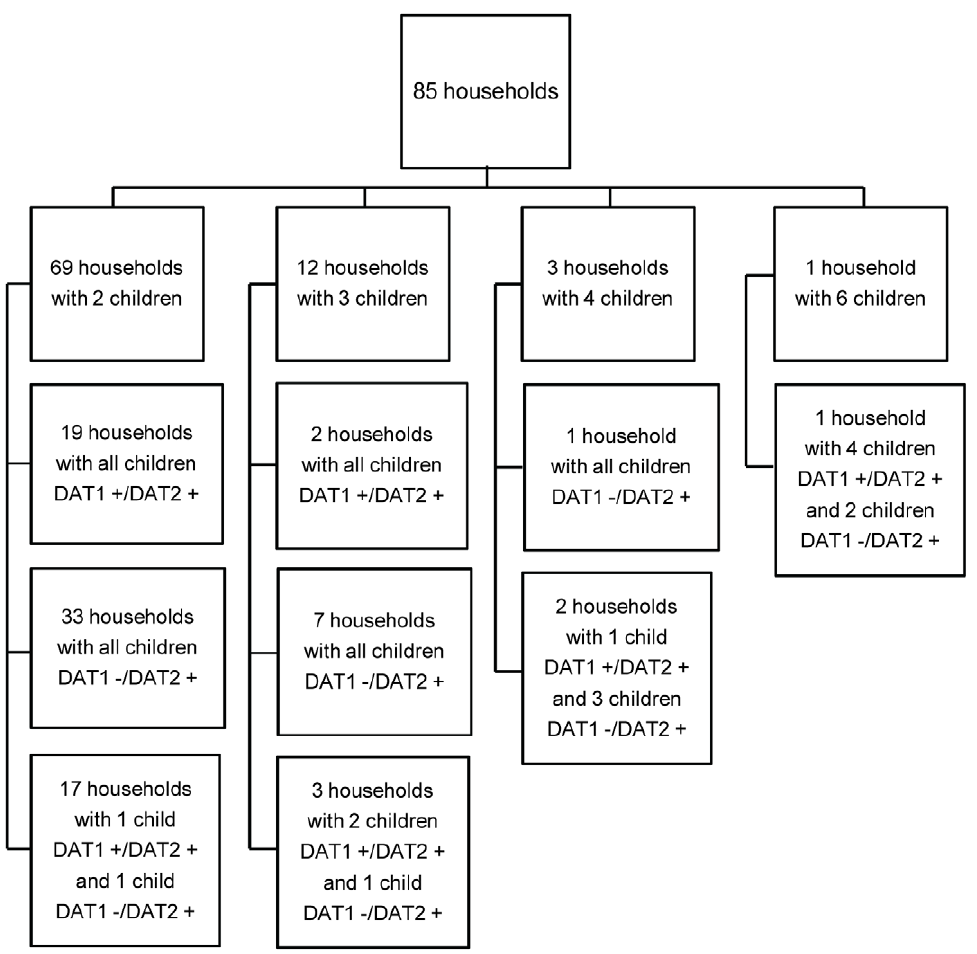
Figure 2. Households with all children tested seropositive for Leishmania at the baseline and/or follow-up surveys. Eighty five households with 2 or more children where all children were DAT positive either in both baseline and follow up surveys, or seroconverted during the follow up period: DAT1 2 children negative in baseline survey, DAT1 + children positive in baseline survey, DAT2 + children positive in follow-up